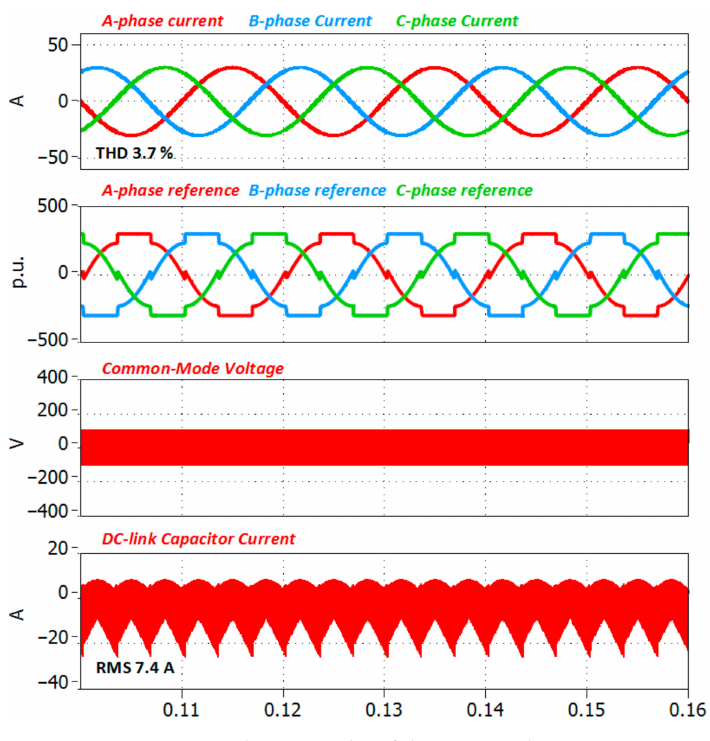
Figure 7. Simulation results of the proposed